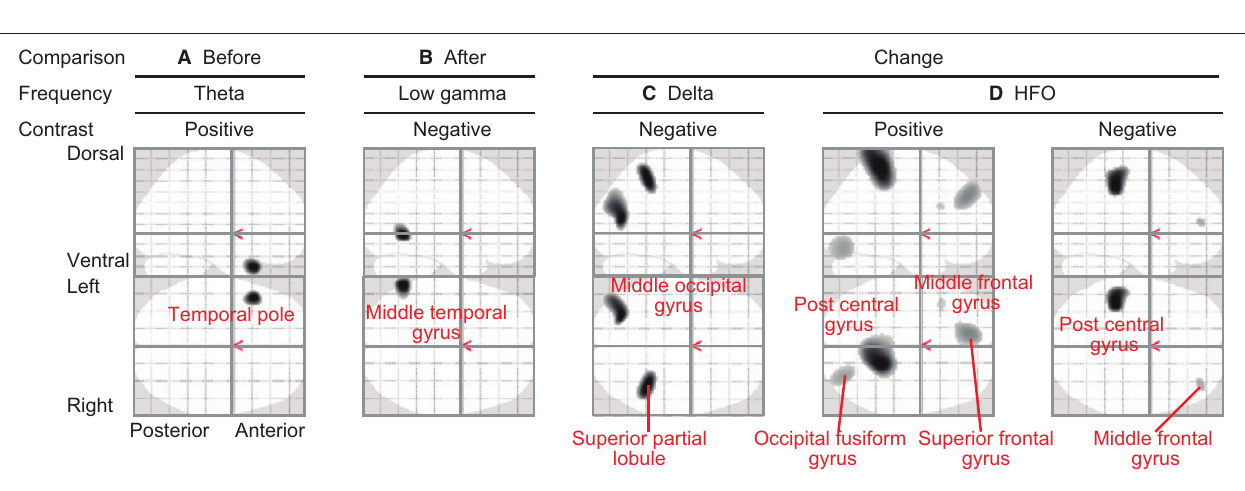
generated a contrast image. The voxels on the contrast image, having statistical values at P < 0.05 after controlling FWE across whole brains, were shown with a greyscale gradient